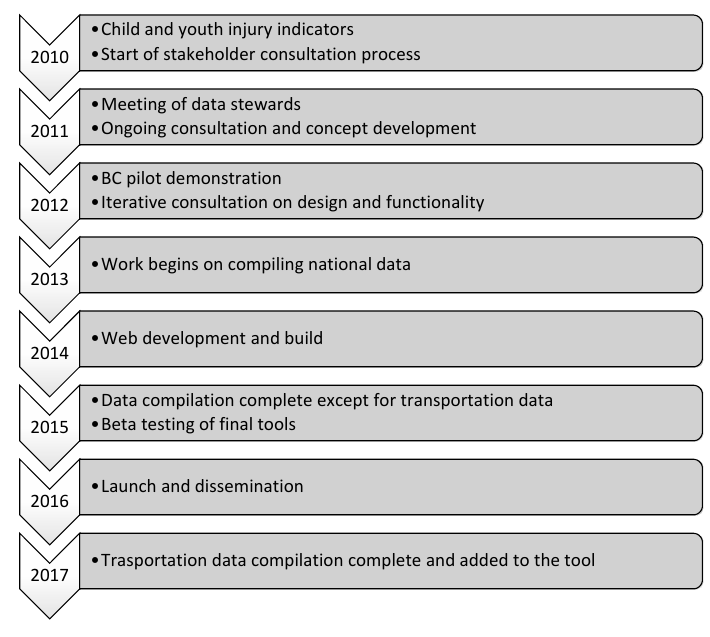
Figure 1. Atlas and dashboard timeline.